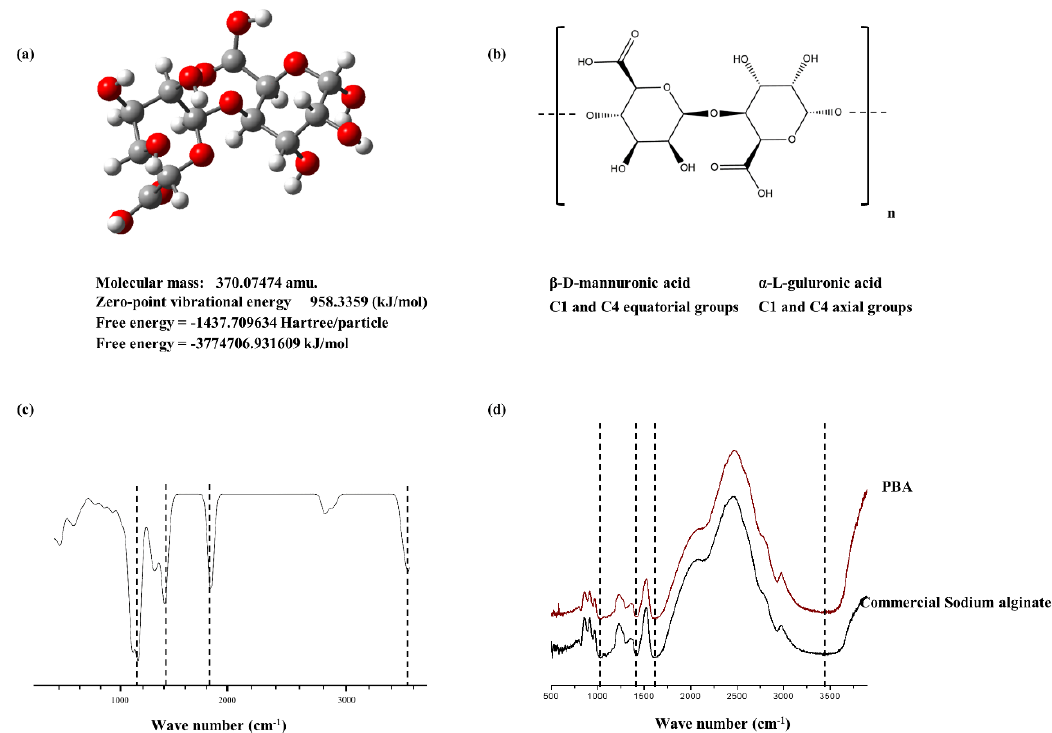
Figure 1. Characterization of alginic acid. ( a ) Structure of constructed dimeric unit of alginic acid 3D, ( b ) Skeletal formula of the alginic acid dimer with its monomeric units representing stereochemistry in 2D, ( c ) Vibrational spectra of alginic acid dimer calculated and constructed with density functional quantum chemical (DFT) calculations using B3LYP level, 6–31G (d,p) basis set, ( d ) FTIR spectroscopic analysis of PBA compared with commercial sodium alginate.